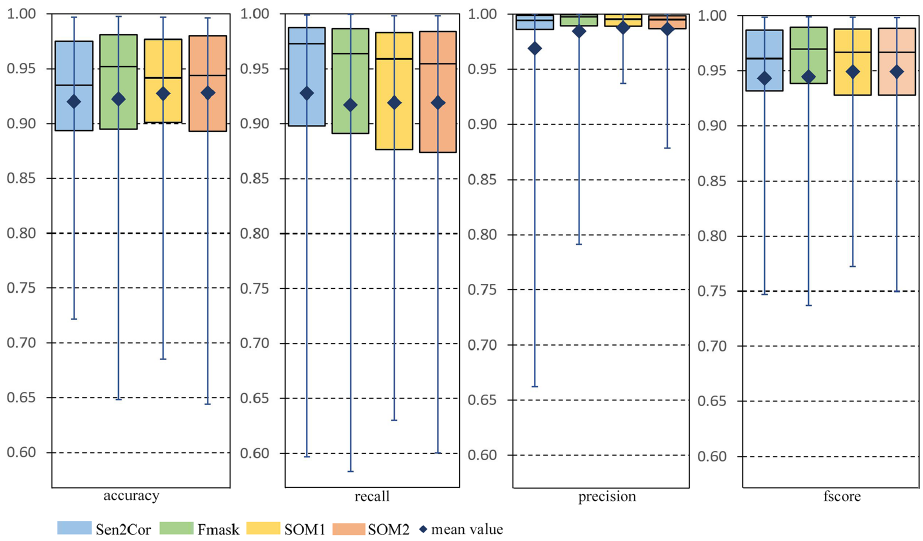
Figure 10. Box plots of the evaluation metrics of the entire test